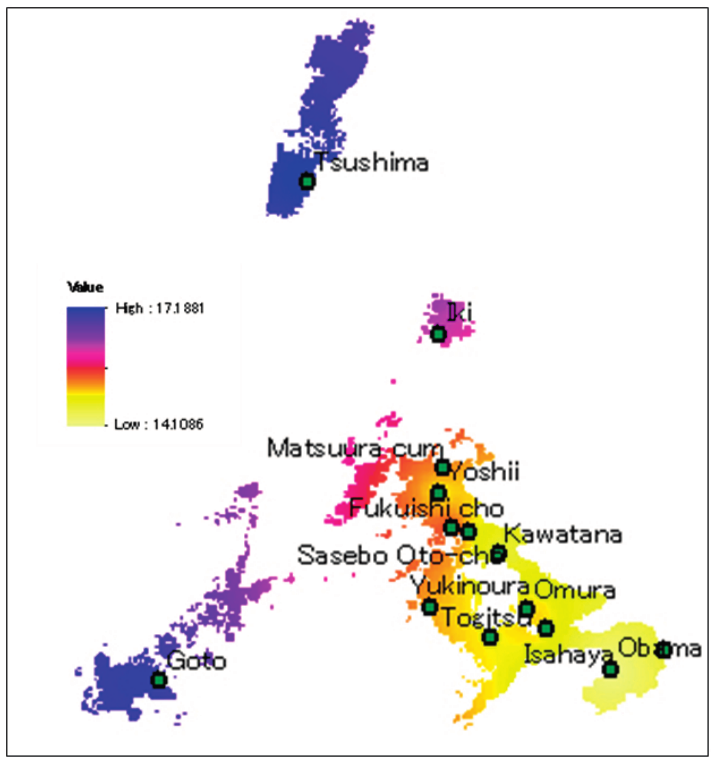
Figure 3. Spatial distribution of PM 2.5 mass concentration in Nagasaki